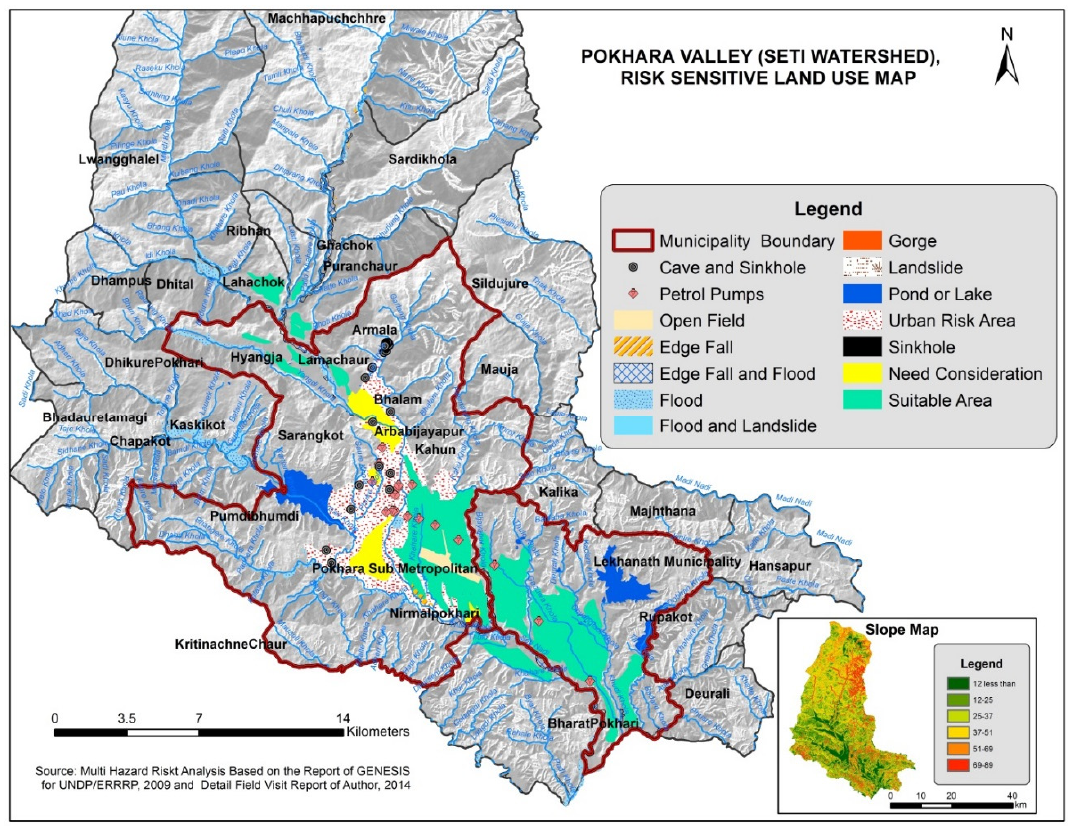
Figure 12. Risk sensitivity